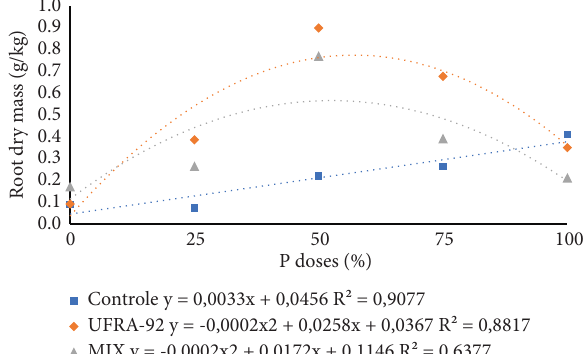
Figure 2: Efect of inoculation with Bacillus subtilis (UFRA-92) and Trichoderma asperellum +UFRA-92 (MIX) as a function of phosphorus doses on the dry mass root of Urochloa brizantha cv.